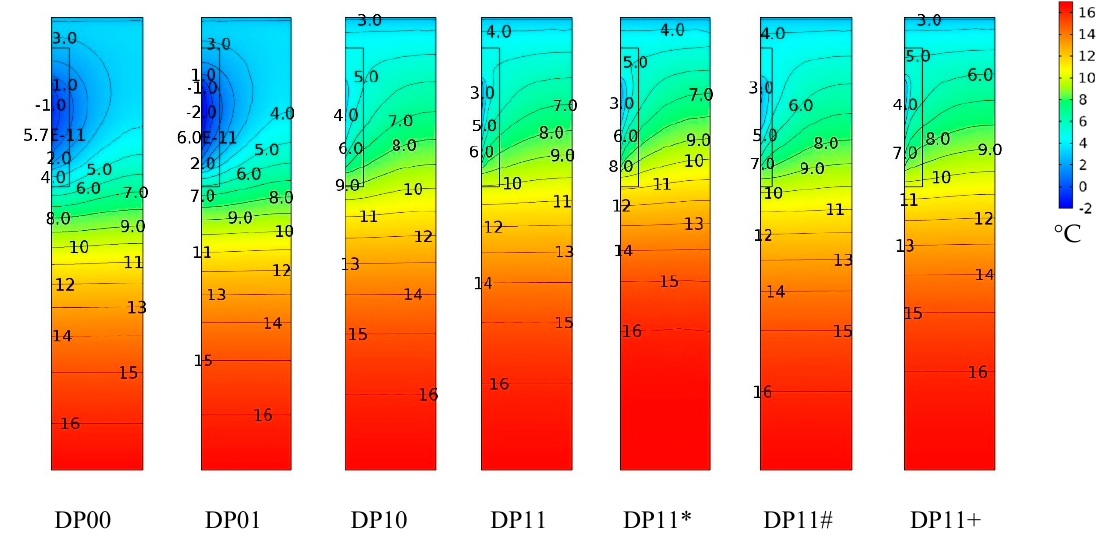
Figure 13. Thermal field at 41.333 days of simulation for cases DP00, DP01, DP10, DP11, DP11*, DP11#, DP11+.